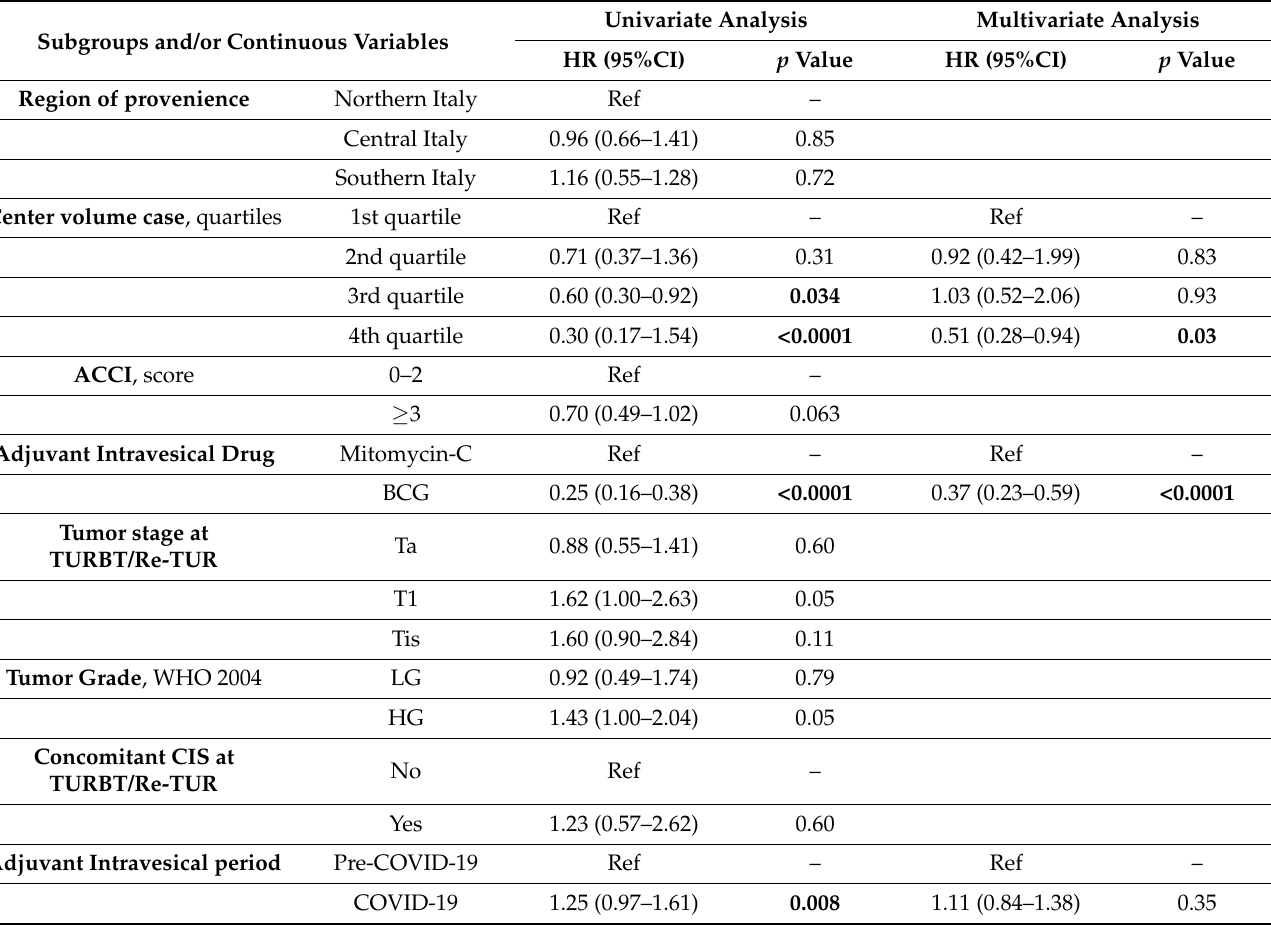
Table 6. Univariable and multivariable logistic regression analysis for delayed time to adjuvant intravesical therapy (maintenance). In bold, value <